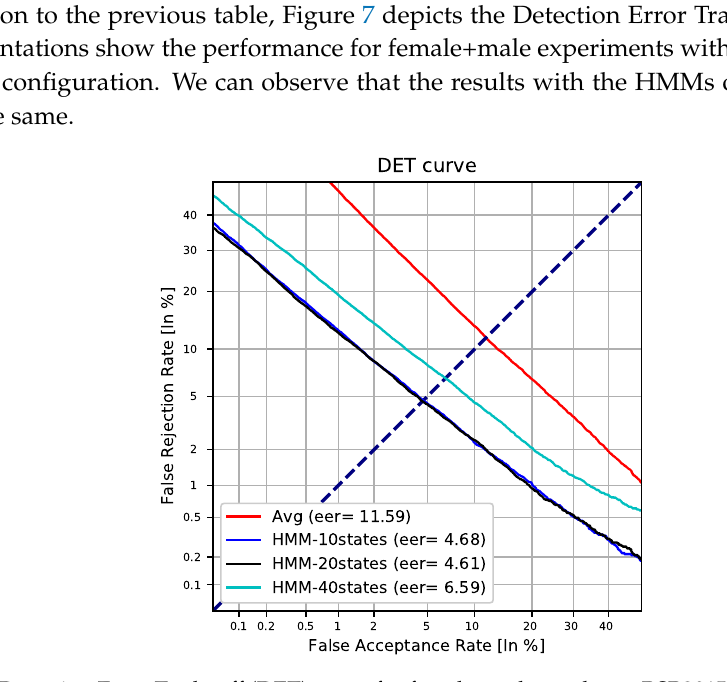
Figure 7. Detection Error Trade-off (DET) curve for female+male results on RSR2015-Part II of the best systems for each pooling